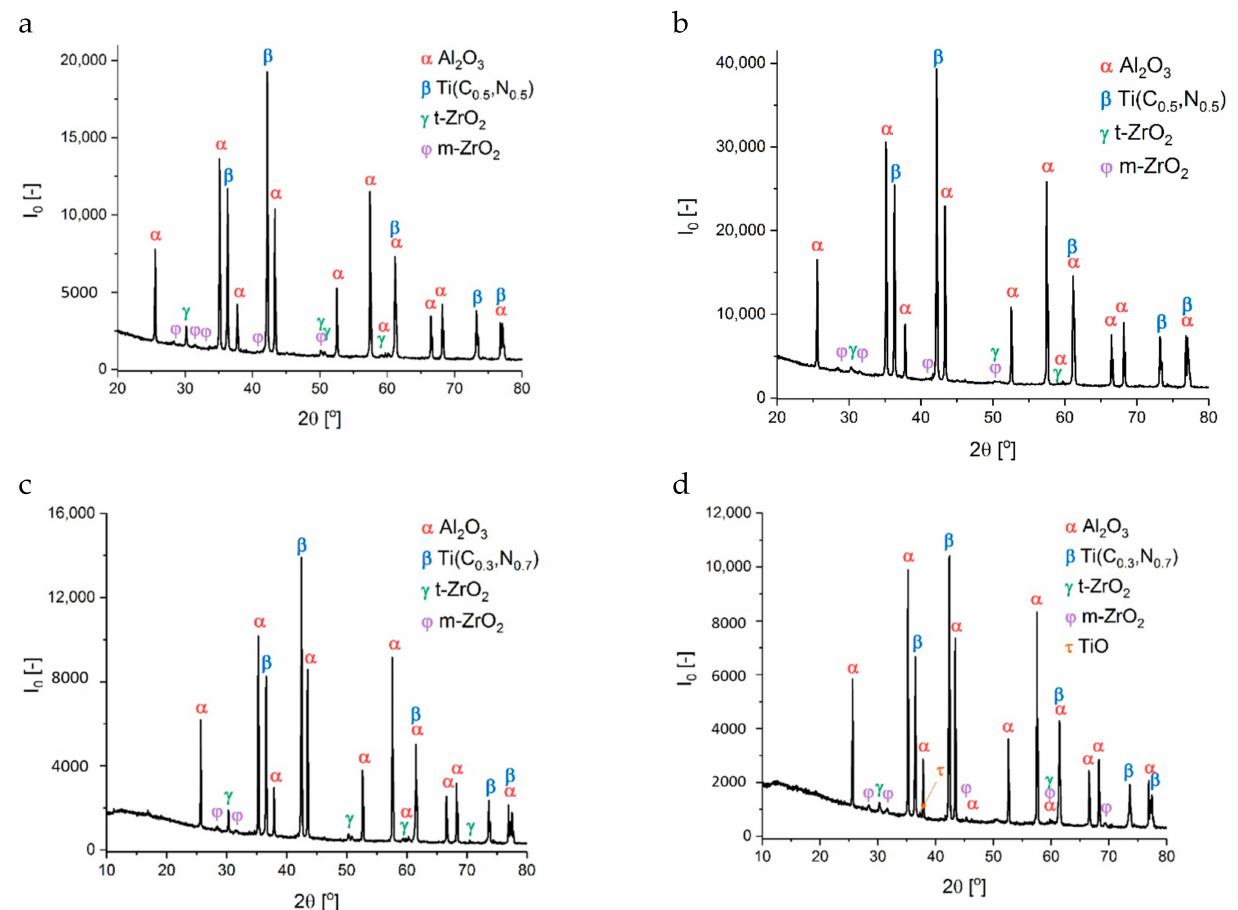
Figure 9. X-ray diffraction analysis of the tested composites, which are identified as ( a ) TICN5.1, ( b ) TICN5.3, ( c ) TICN3.1, and ( d )